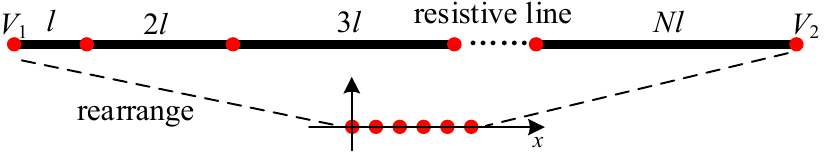
Figure 1. The schematic diagram of a resistive line.